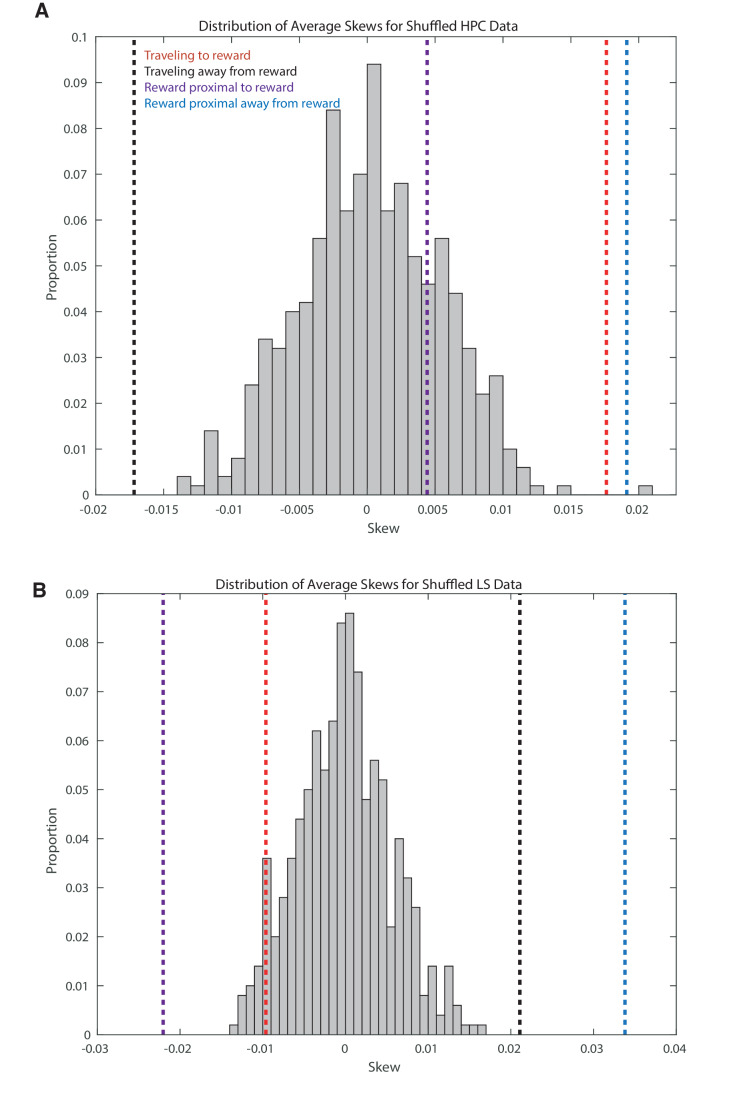
Distribution of skews for shuffled data.(A) Distribution of skews for HPC shuffled data. A random distribution was obtained by shuffling firing rates within a firing field and then computing skew for the shuffled data. Average skew for 500 shuffled distributions were computed. The average skews for the actual data depicted in figure 5 are marked with dotted lines. (B) Same as A but for LS.